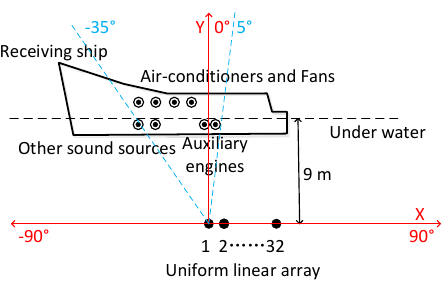
( d ) Figure 10. Spatial beam spectra after processing the first second data by four methods. ( a )Spatial beam spectra after processing the first second data by CSS-CS; ( b ) Spatial beam spectra after processing the first second data by ISS-CS; ( c ) Spatial beam spectra after processing the first second data by CSS-MVDR; ( d ) Spatial beam spectra after processing the first second data by ISS-MVDR. 4.2. Marine Trial Data Verification and Analysis We carried out a marine trial near the Laopian Island off the Tiger Beach in Bohai Bay, Dalian, China. The depth of the sea area is 40–50 m, and the ocean current velocity is about 3 knots. The array used in the marine trial is a rigid horizontal ULA with 32 elements, as shown in Figure 11. During the marine trial, the 1st, 2nd, and 32nd element were damaged, so the number of effective array elements was 29. The hydrophone spacing is 0.225 m and the receiving array depth is about 9 m. ( a ) ( b ) Figure 11. The ULA used in the marine trial. ( a ) Partial enlargement of the ULA; ( b ) The photograph of the ULA before it was put into water.